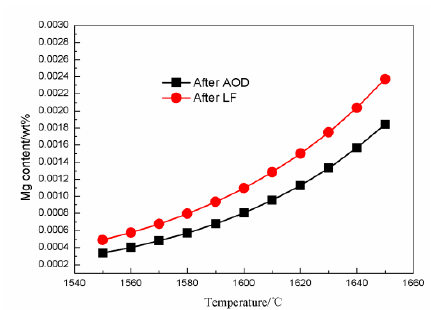
Figure 10. Effect of the slag on the content of Mg in steel.